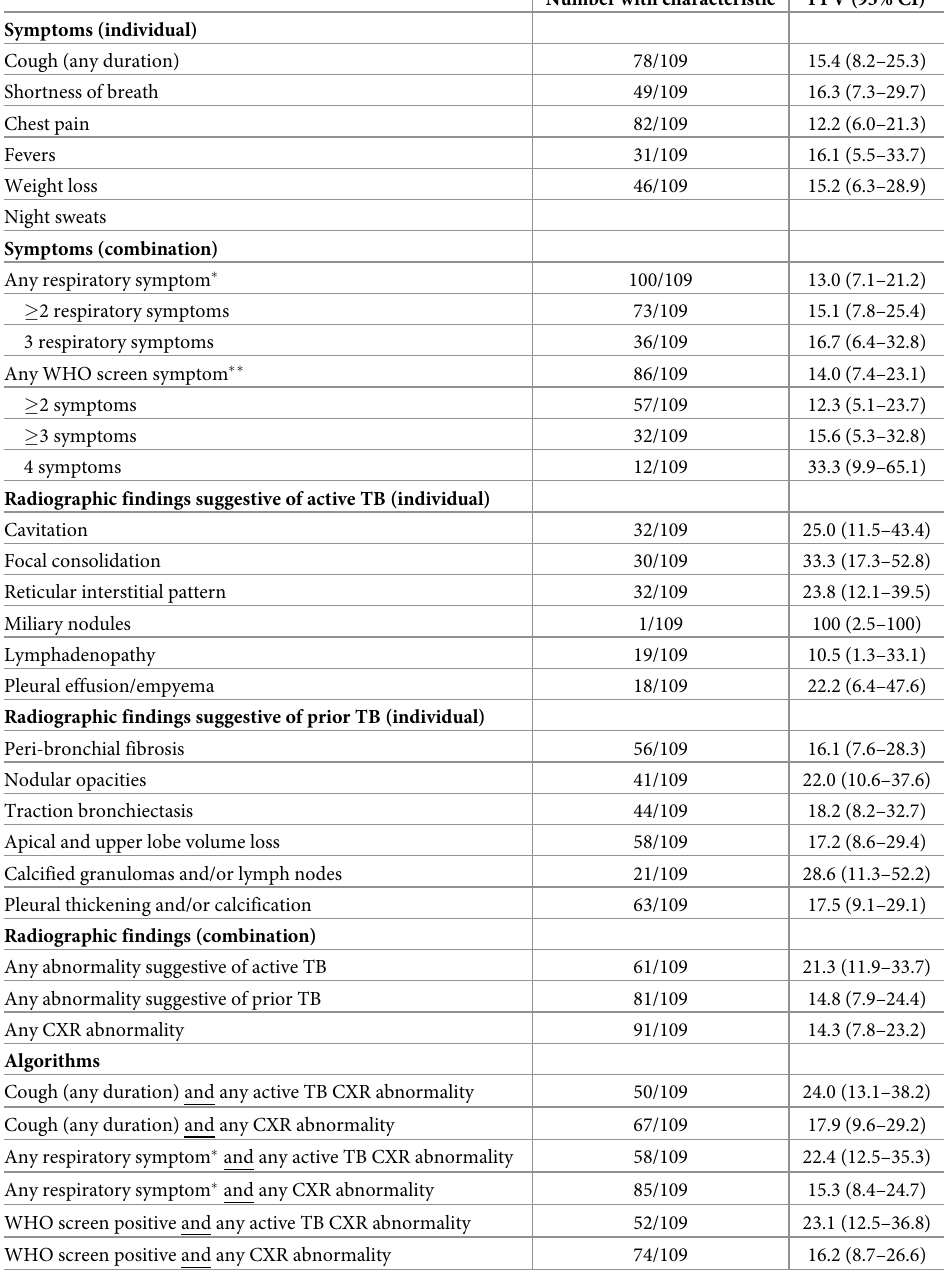
Table 4. The positive predictive of clinical symptoms and chest radiography findings among presumptive TB patients previously treated for TB (n =